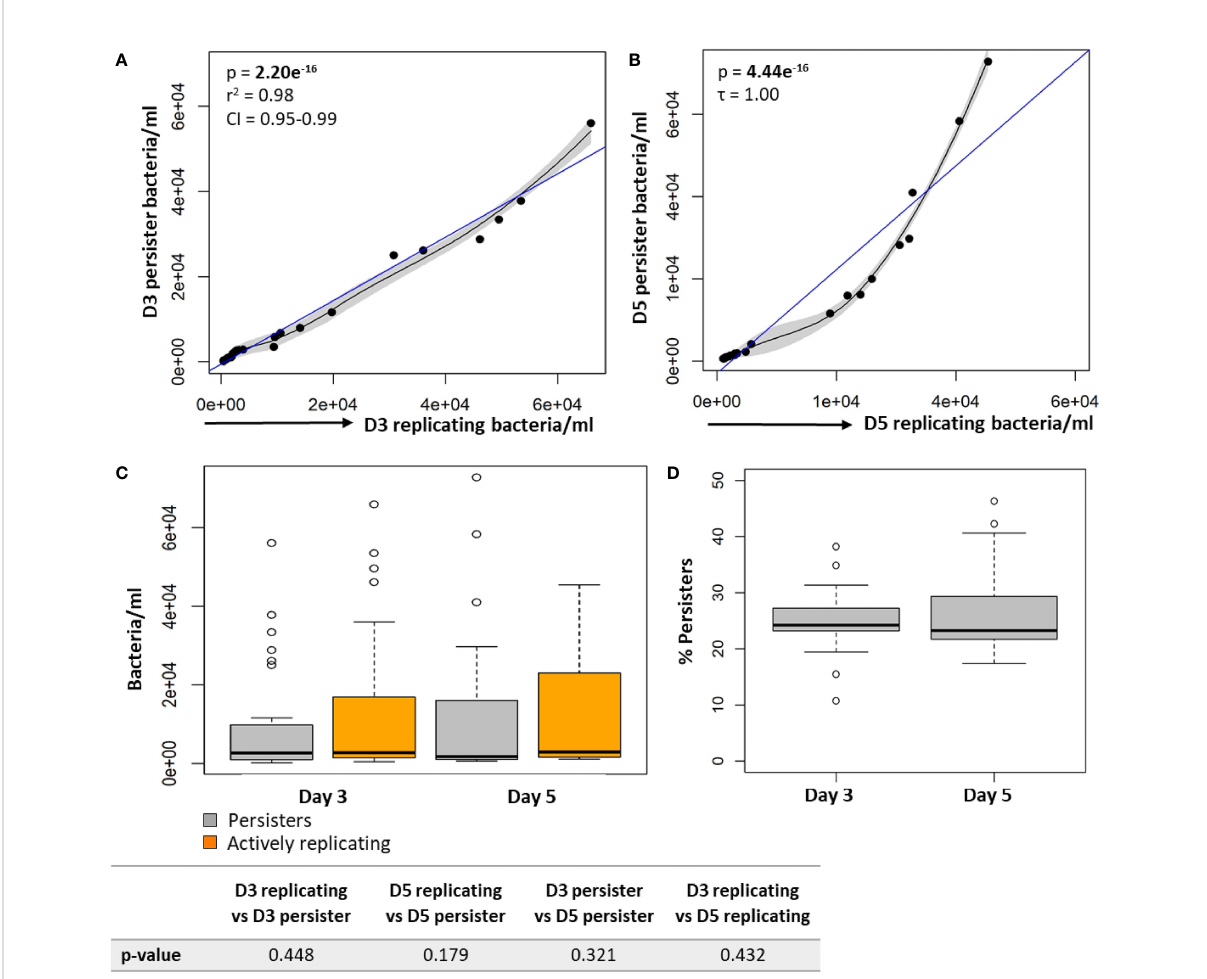
FIGURE 4 Persister numbers correlated with the number of intracellular growing mycobacteria in macrophages. Signi fi cant positive correlations were observed between actively replicating bacteria and respective persister numbers at (A) day 3 and (B) day 5. (C) No signi fi cant difference between bacterial numbers was observed between day 3 and day 5 (Wilcoxon test). (D) The median percentage of persisters in relation to the respective intracellular bacterial numbers was assessed. No signi fi cant differences in the median percentage of persisters between days 3 and 5 was observed (p = 0.784; Wilcoxon test). Correlations were assessed using the Pearson ’ s product-moment (linear), or Kendall ’ s Tau correlation (non- linear). The blue line represents the regression line for the correlation analyses (Pearson and Kendall), while the black line and associated shaded area represents the local non-linear regression and 95% con fi dence interval. Box and whisker plots express distribution of data, indicating the median (bold line), interquartile range (box), and range (whiskers). The data was independently conducted in 7 biological experiments, including technical triplicates. Signi fi cant p-values (p < 0.05) are shown in bold. r 2 , Pearson ’ s correlation coef fi cient squared; CI, 95% con fi dence interval; t , Tau correlation coef fi